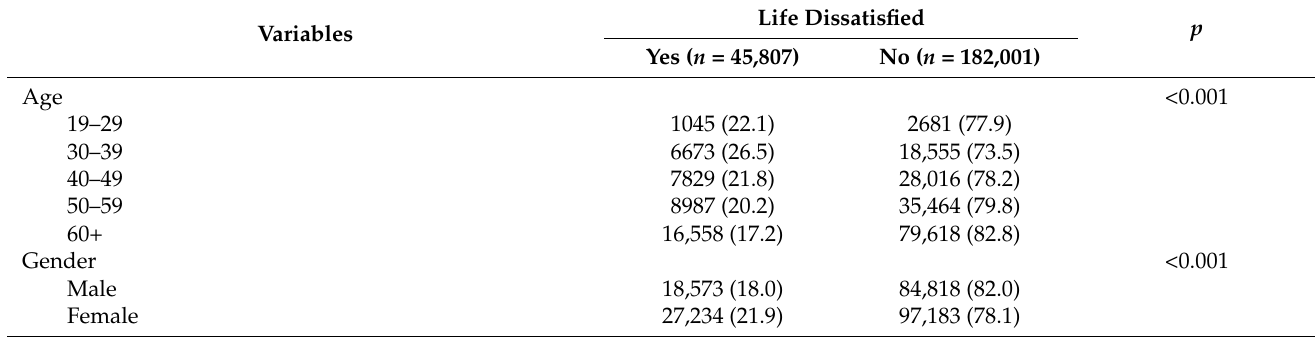
Table 1. The characteristics of the life dissatisfied subjects during the COVID-19 pandemic, n (%).